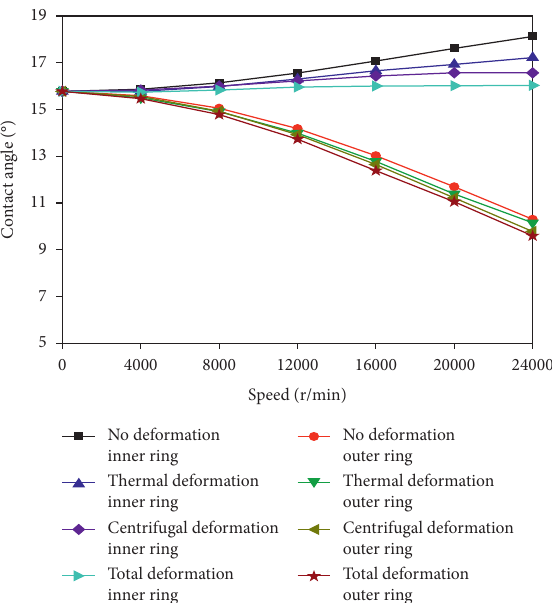
Figure 14: Influences of the speed and deformation on the contact angle.